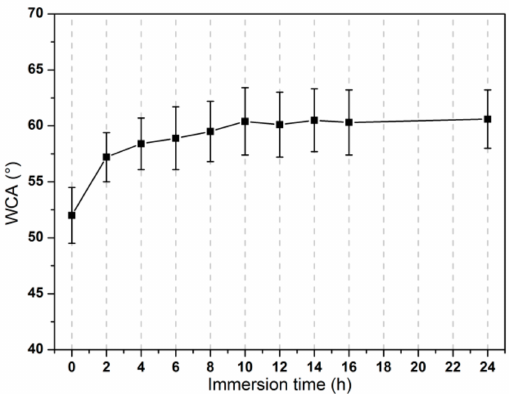
Figure 1. The influence of immersion time of GO assembly upon WCA values for GO-APS coating.